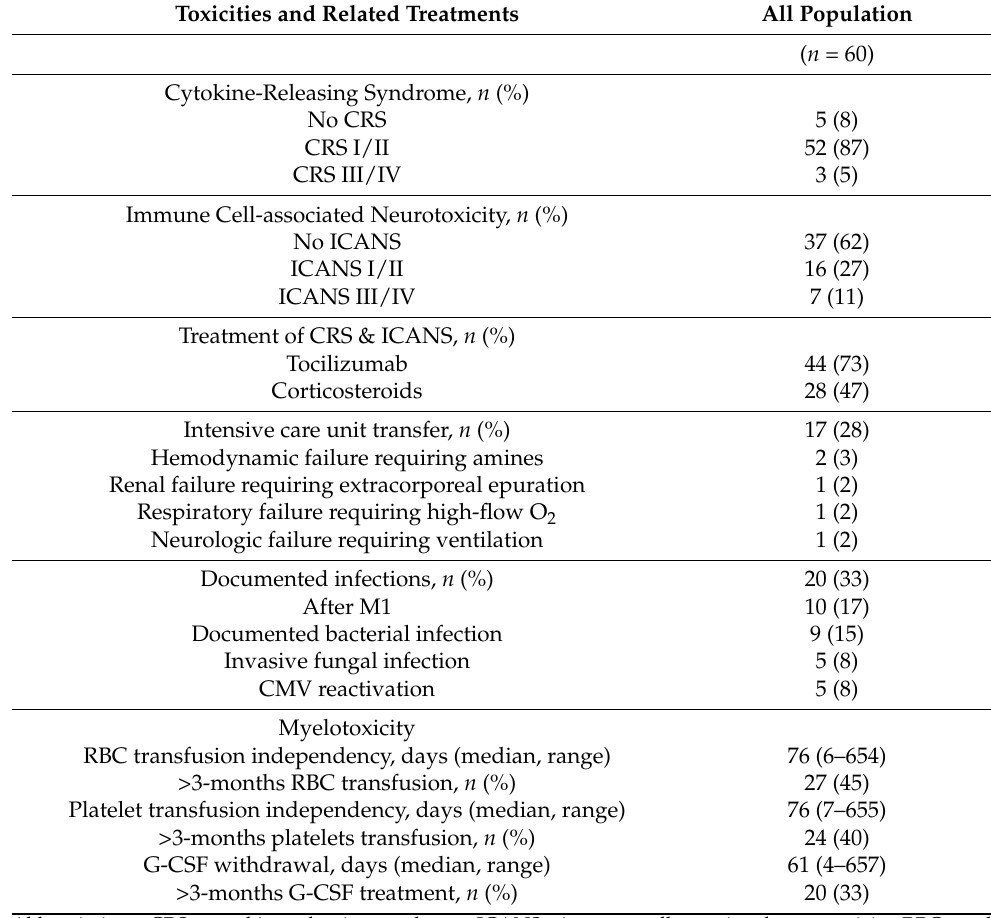
Table 2. Toxicities after CAR T-cell